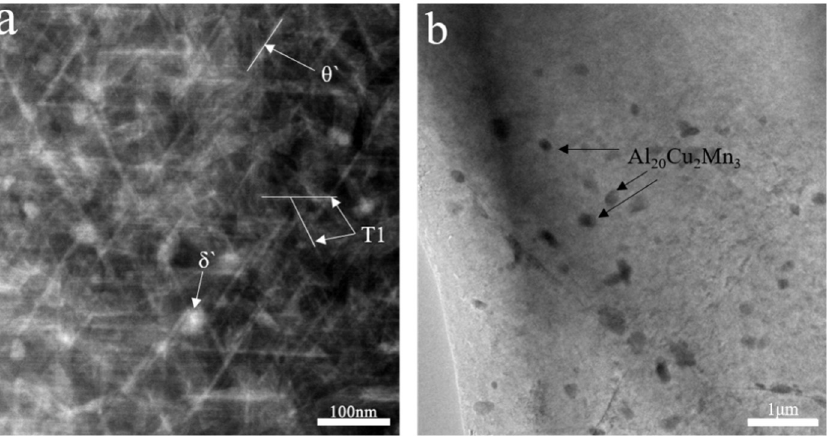
Figure 11. TEM (Transmission Electron Microscope) images of the aged alloy: microstructural morphology of ( a ) nano-scale precipitates of θ ', T1 and δ ’, and ( b ) Al 20 Cu 2 Mn 3 phase in the aged alloys.